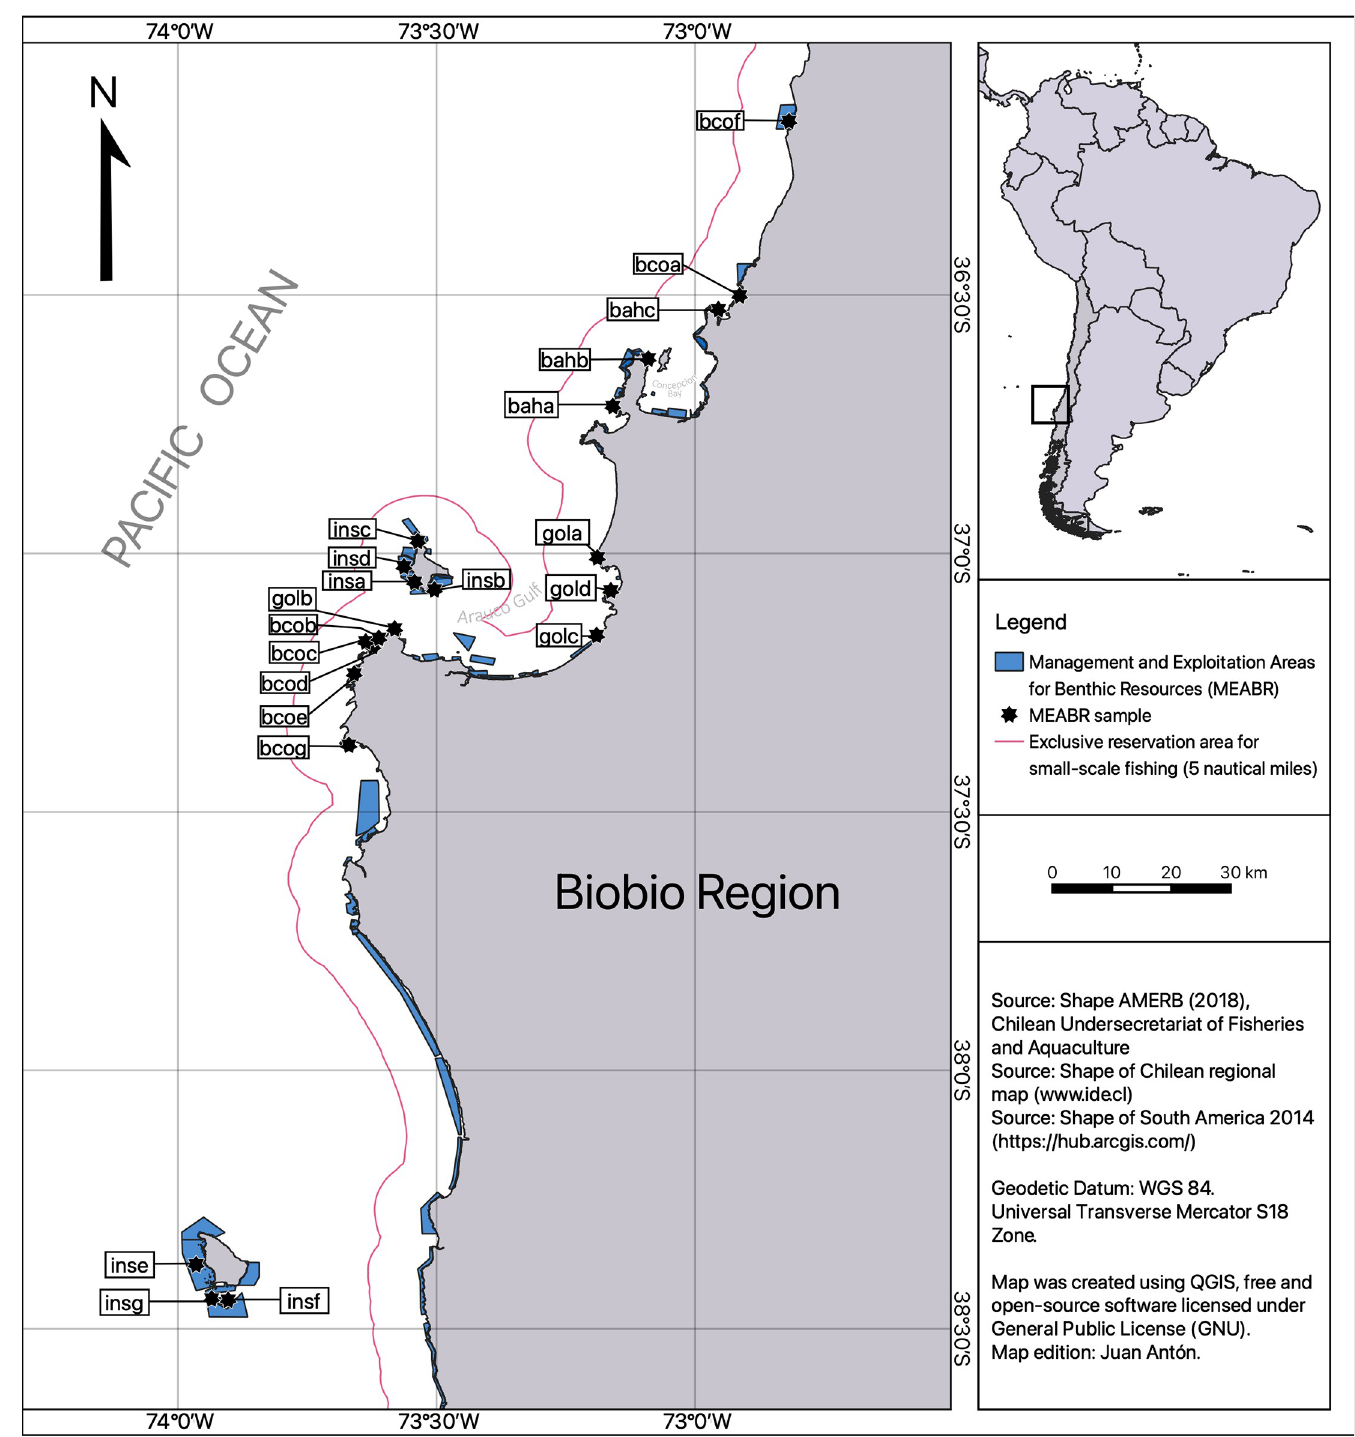
Fig 1. Map of the study area: Fishing coves and MEABRs in the Biobio Region, Chile. MEABR’s Codes description (sampled): baha = San Vicente, bahb = Candelaria-Cantera, bahc = Rari, bcoa = Dichato, bcob = Punta Raimenco, bcoc = Bajo Rumena, bcod = Rumena, bcoe = Los Piures, bcof = Cobquecura sector A, bcog = Puerto Yana, gola = Maule, golb = Punta Lavapie, golc = Pueblo Hundido, gold = Laraquete, insa = Los Partidos, insb = Puerto Sur, insc = Pueblo Norte sector B, insd = Punta Cadena, inse = Weste Isla Mocha, insf = Quechol, insg = Quechol Sur. “Reprinted from Shape AMERB (2018), Chilean Undersecretariat for Fisheries and Aquaculture under a CC BY license, with permission from PLOS journal, original copyright 2021”.